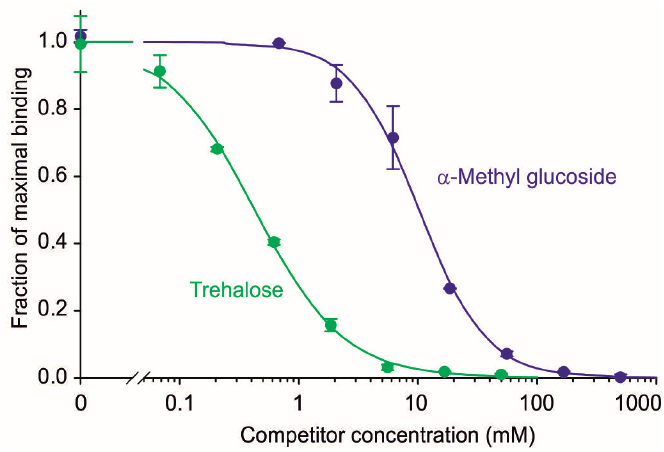
Figure 3. Competition binding assays comparing binding of simple sugars to mouse mincle. Biotin-tagged mincle immobilized in streptavidin-coated wells was probed with 125 I-Man-BSA in the presence of various concentrations of competing ligands. The data were fitted to a simple binding equation [14] using a non-linear least squares fitting program to determine K I values. Circles represent experimental values, with standard deviations for individual data points indicated by error bars, and the fitted curve is shown by the solid